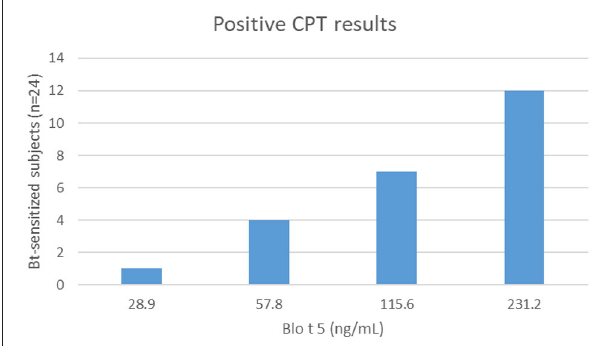
FIGURE 1 | Respondents to conjunctival provocation tests (CPT) and concentrations of Blo t 5.